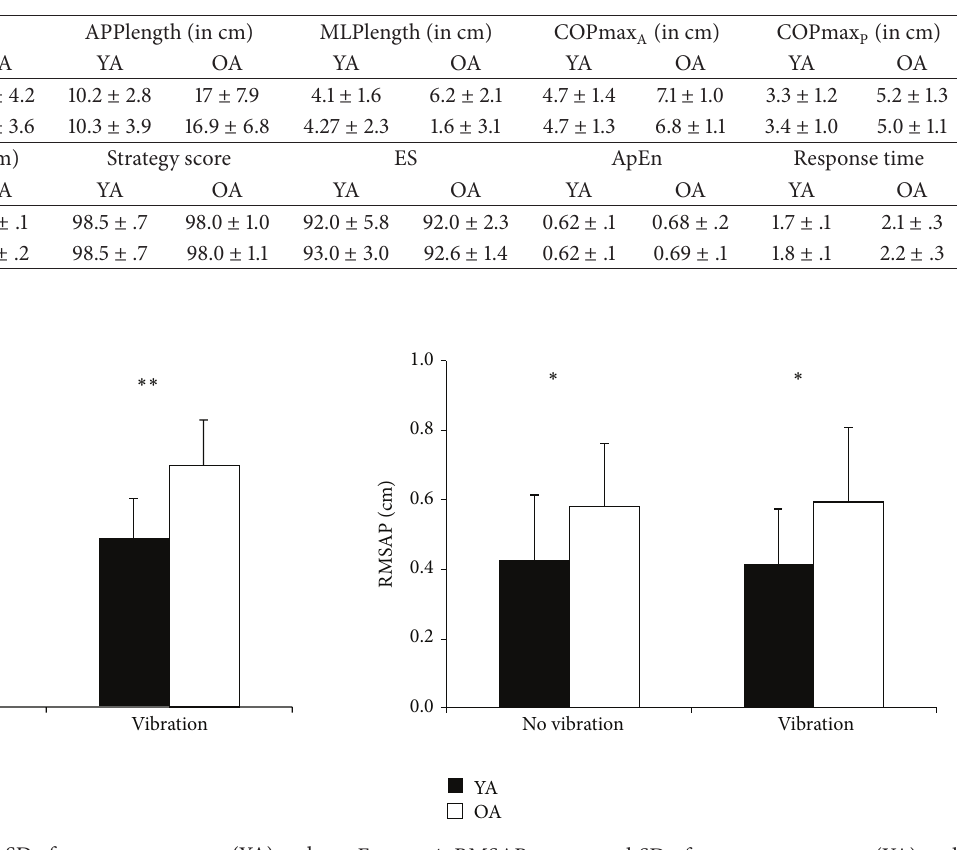
Figure 4: RMSAP means and SD of younger age group (YA) and older age group (OA) without vibration and with vibration. ∗ = 𝑝 < 0.05 .